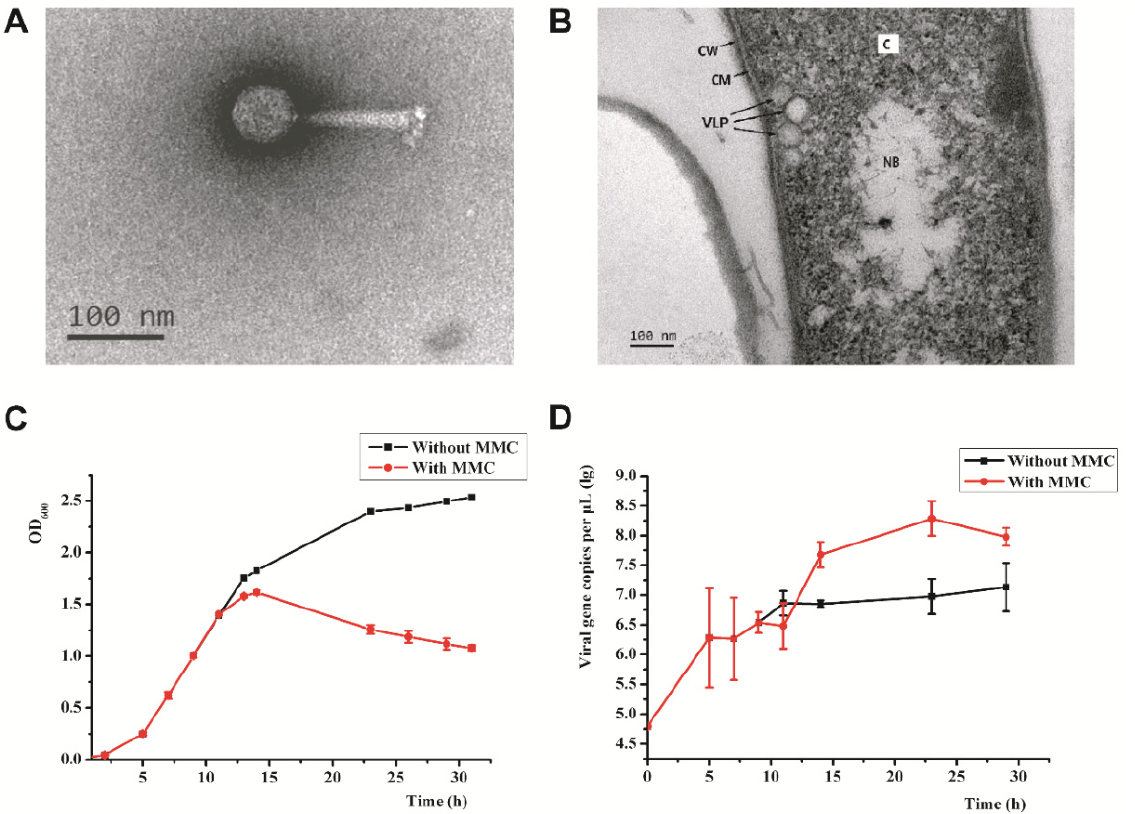
Figure 1. Morphology and induction of PVJ1: ( A ) transmission electron micrographs of PVJ1; ( B ) thin section of a Psychrobacillus sp. GC2J1 cell following treatment with mitomycin C. CM, cytoplas- mic membrane; NB, nuclear body; C, cytoplasm; CW, cell wall; VLP, virus-like particle; ( C ) effect of mitomycin C treatment on the growth of Psychrobacillus sp. GC2J1; ( D ) titer of PVJ1 during mitomy- cin C induction experiment.